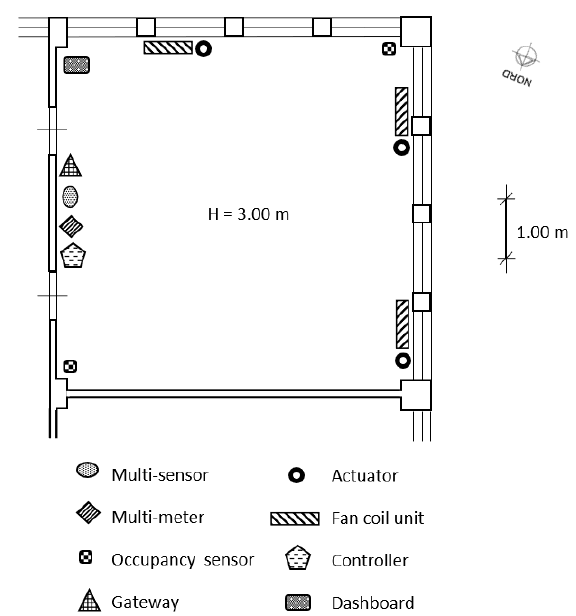
Figure 3. Map of the demo site, with indication on the system main components localization.